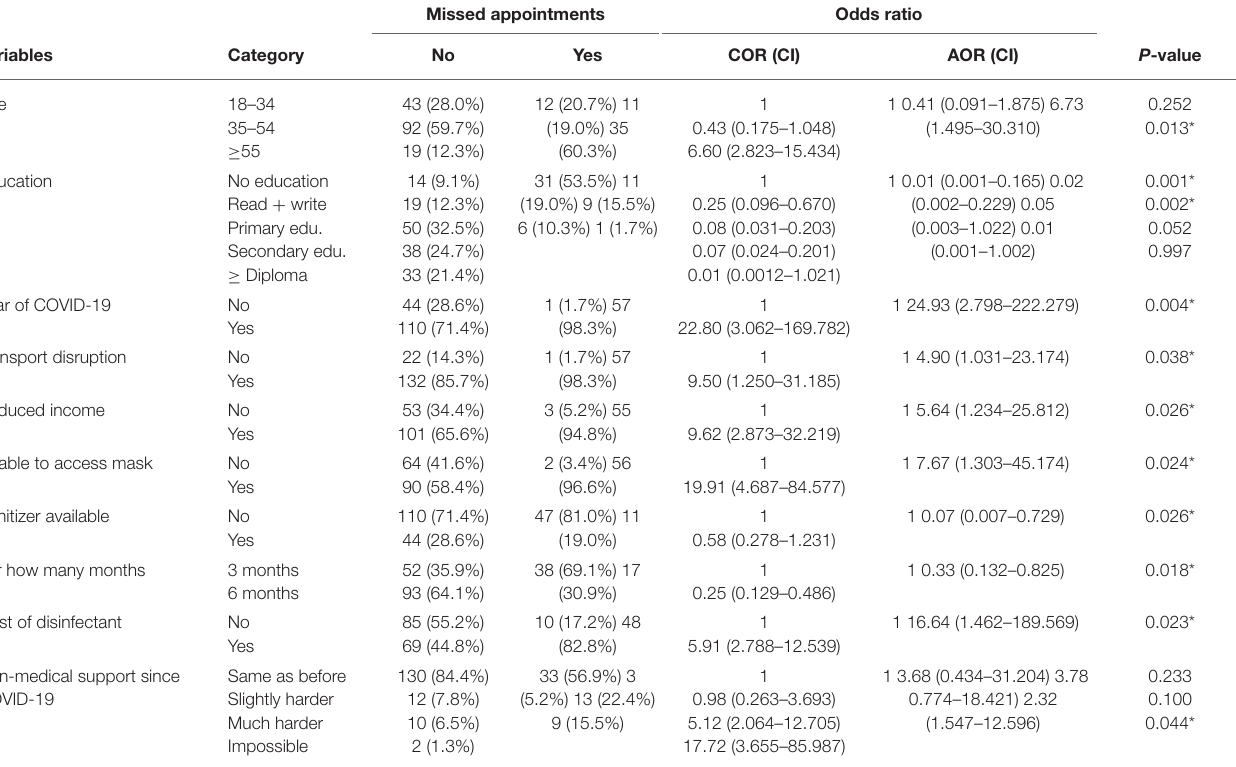
TABLE 8 | Bivariate and multivariate logistic regression analysis of missing appointments/visits for the medication refill variable, Addis Ababa, Ethiopia, 2021. Missed appointments